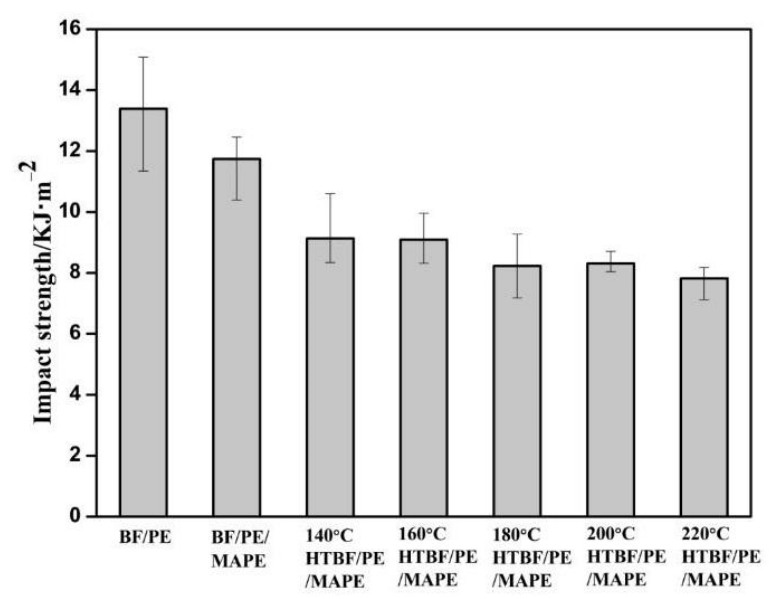
Figure 10. Impact strength of bamboo plastic composites.